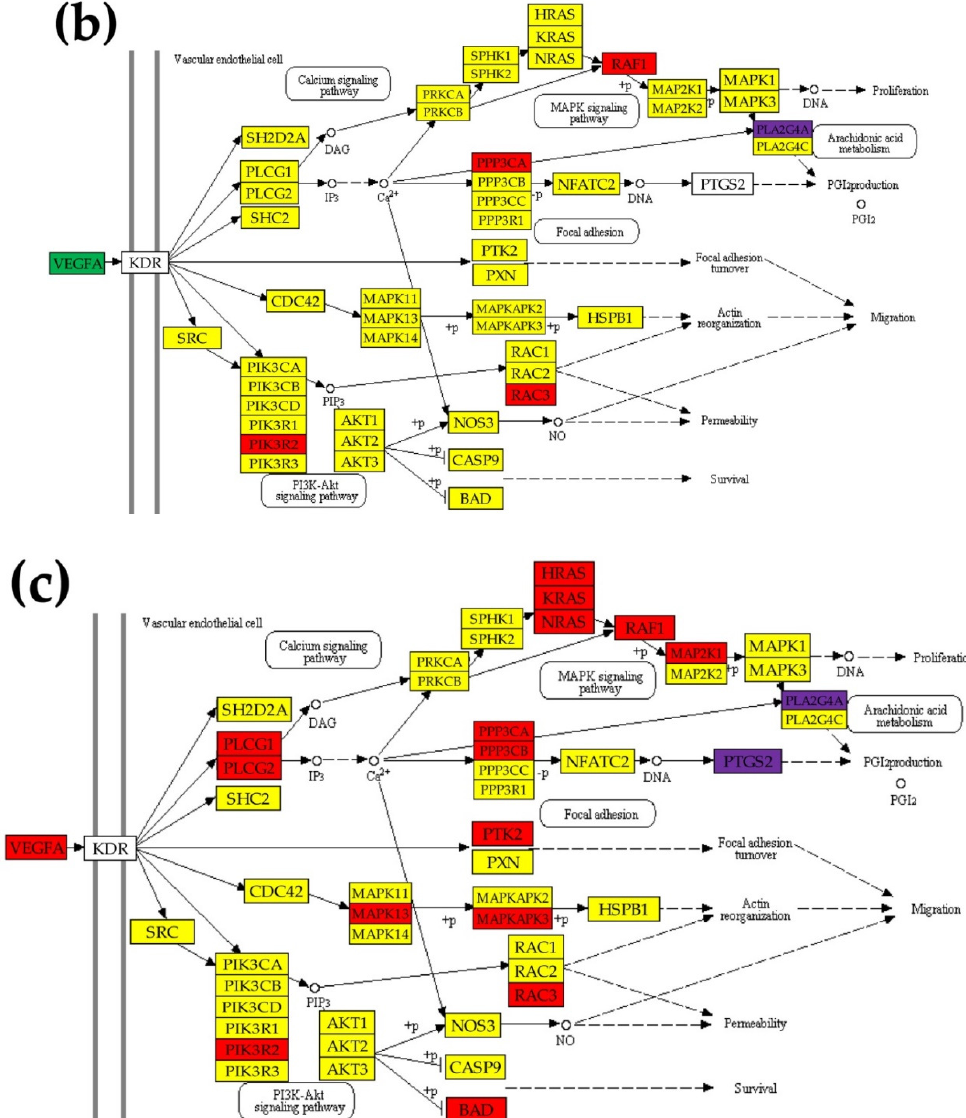
Figure 4. Regulation of the VEGF signaling pathway in ( a ) PTA, ( b ) PTB, and ( c ) CWM. Regulated genes: HRAS (Harvey rat sarcoma viral oncogene homolog), KRAS (Kirsten rat sarcoma viral oncogene homolog), MAPK11/13 (mitogen-activated protein kinases 11/13), NRAS (neuroblastoma RAS viral (v-ras) oncogene homolog), PIK3R2 (phosphoinositide-3-kinase, regulatory subunit 2 (beta)), PLCG2 (phospholipase C, gamma 2 (phosphatidylinositol-specific)), PTK2 (protein tyrosine kinase 2), and SRC (v-src avian sarcoma (Schmidt-Ruppin A-2) viral oncogene homolog).